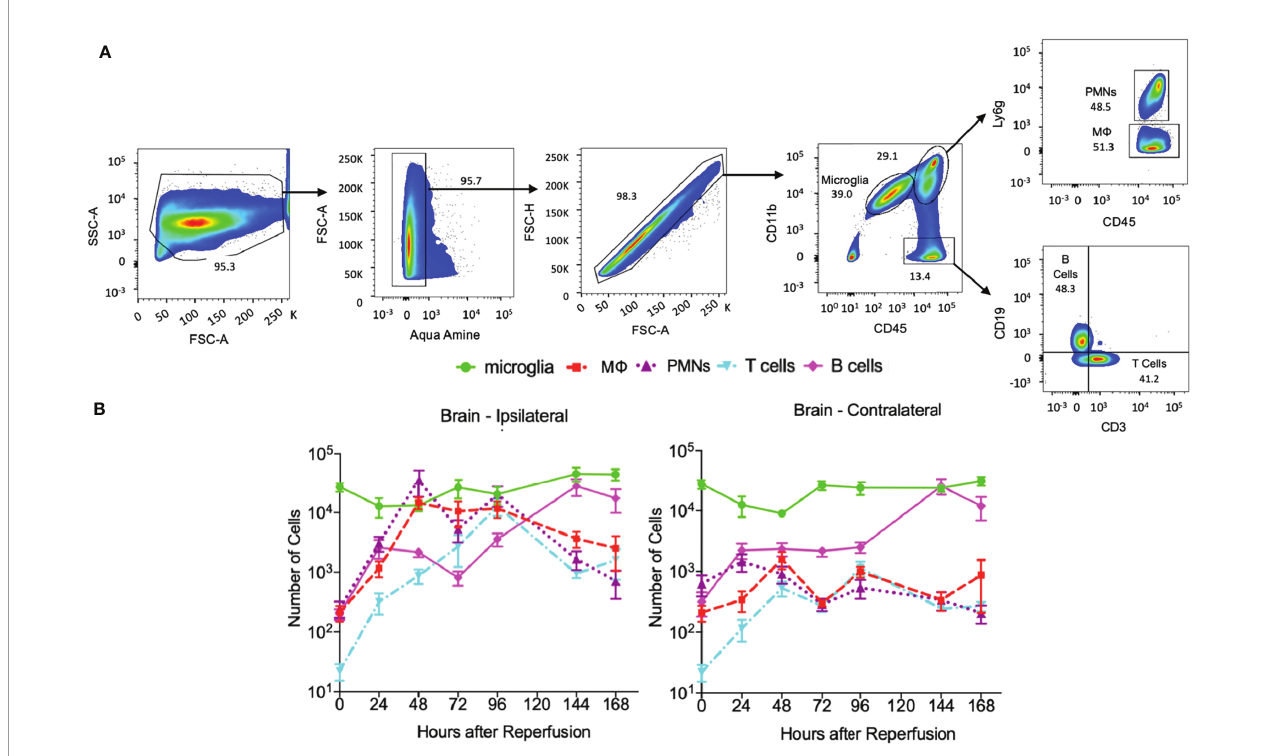
FIGURE 4 | The dynamics of immune cells at ipsilateral and contralateralhemispheres post stroke and sham. (A) fl ow cytometry plots showing the gate strategy for identi fi cation of microglia, neutrophil (PMNs), macrophage (M F ), T cells and B cells. In brief, alive singlet cells from brain were chosen for analysis on multiple biomarkers expression level. In particular, microglia were identi fi ed as CD45 + CD11bMed, neutrophils as CD45+CD11b hi Ly6G + , macrophage as CD45 + CD11b hi Ly6G-, T cells as CD45 + CD11b-CD3 + CD19- and B cells as CD45 + CD11b-CD3 + CD19-. (B) A log-scale fi gure shows the number of various immune cells present in brain until 7 days post stroke. N=7-10 mice were used across the 7 days of analysis post